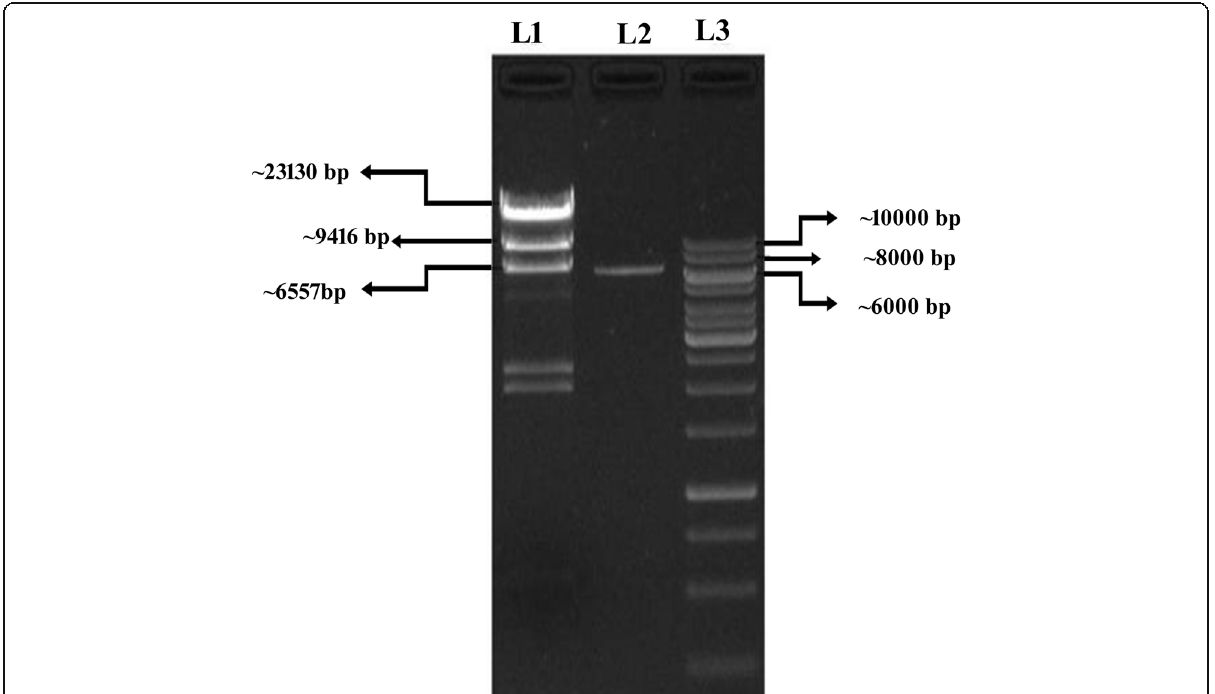
Fig. 5 Long-range PCR product quality check on 0.8% agarose gel. Lane 1, Lamda DNA/HindIII DNA ladder; lane 2, long-range PCR product; and